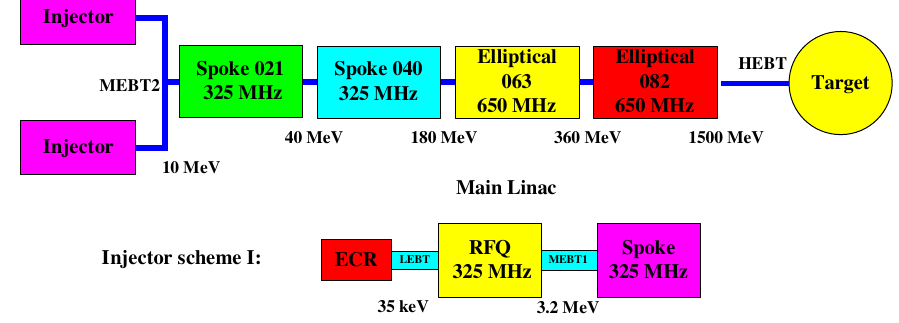
FIG. 1. The general layout of the ADS linac in